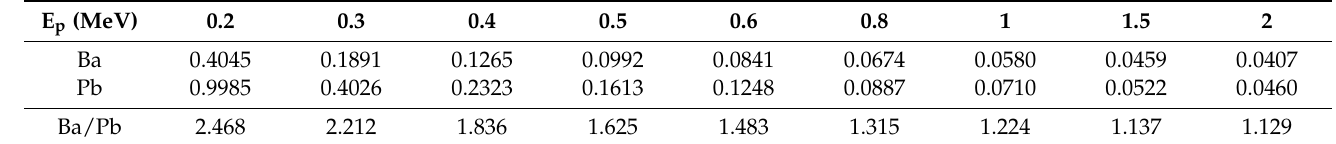
Table 3. Mass attenuation coefficient µ m (cm 2 /g) of Ba and